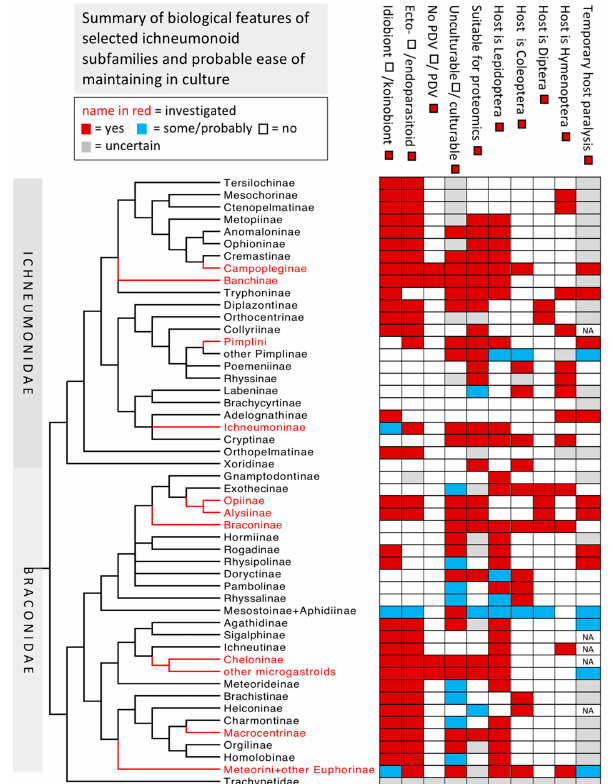
Figure 1. Summary of biological features of selected ichneumonoid subfamilies and probable ease of maintaining in culture. For ease of viewing the following rare subfamilies have been omitted: the braconids—Acampsohelconinae, Amicrocentrinae, Apozyginae, Maxfischeriinae, Microtypi- nae, Telengaiinae and Xiphozelinae; the ichneumonids—Acaenitinae, Agriotypinae, Clasinae, Cylloceriinae, Diacritinae, Eucerotinae, Hybrizontinae, Masoninae, Microleptinae, Nesomesochori- nae, Oxytorinae, Pedunculinae, Sisyrostolinae and Tatogastrinae. (Phylogeny hand-drawn based upon a consensus from